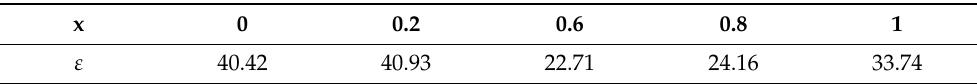
Table 9. ε value at temperature 500 K and frequency of 10 kHz of Ni + 2 0.8, and